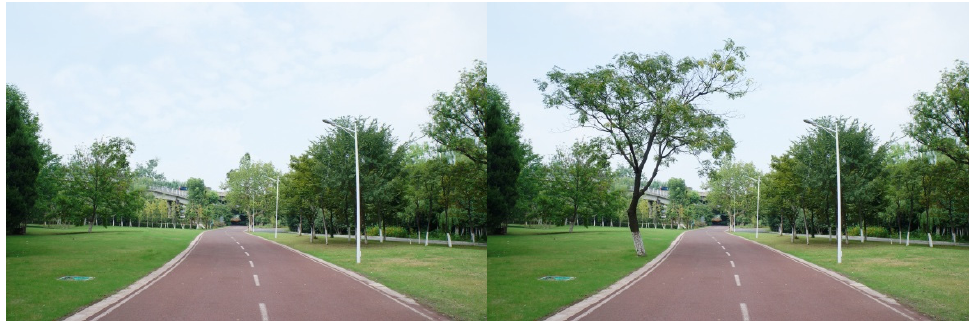
Figure 9. Example: Canopy trees (the overhead canopy tree was removed).